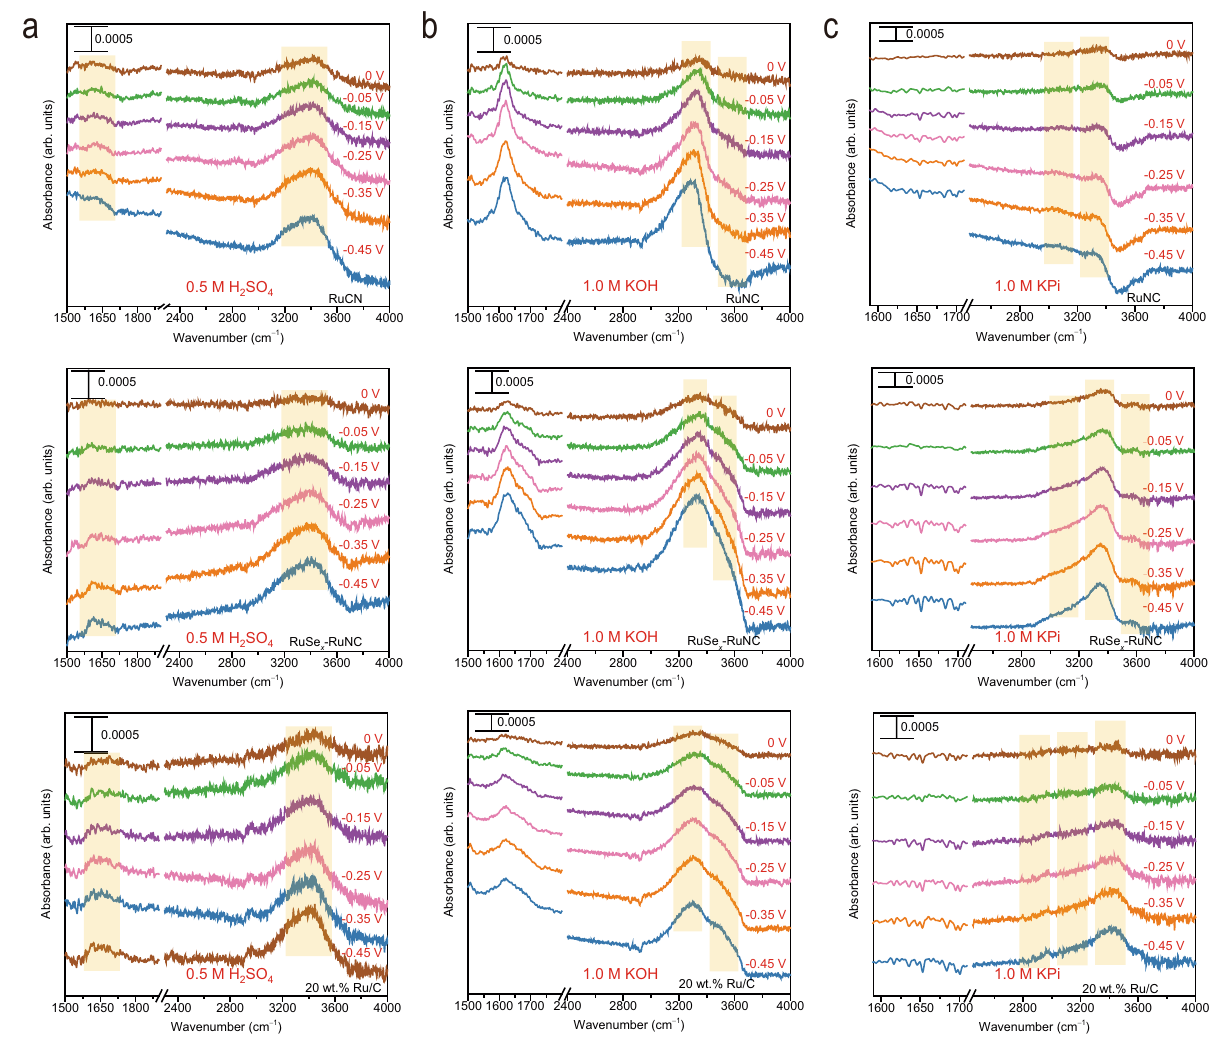
Fig. 5 | Operando spectroscopic characterizations. ATR-SEIRAS results in a acid, b alkaline, c neutral media,